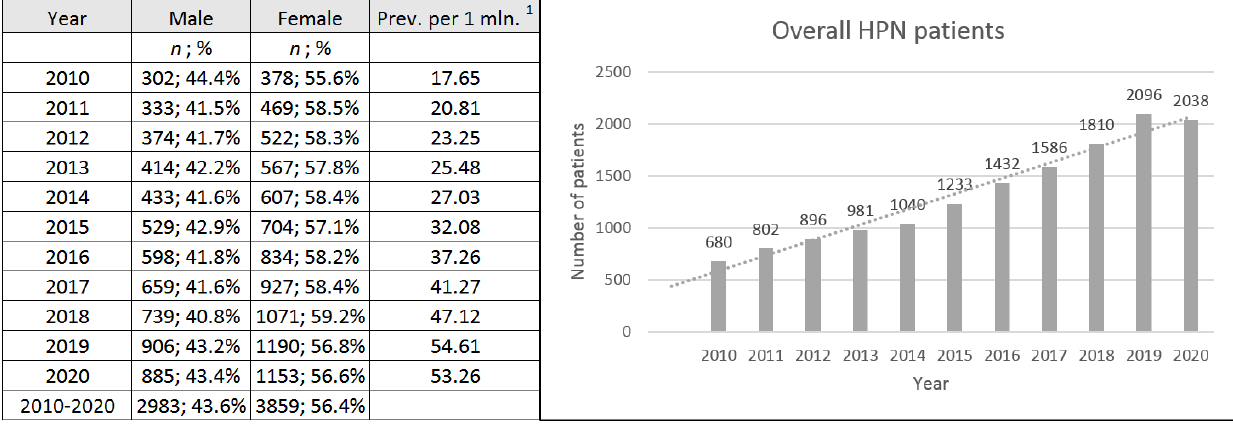
Figure 1. Prevalence of home parenteral nutrition in Poland. 1 — Prevalence of HPN patients per 1 million citizens.